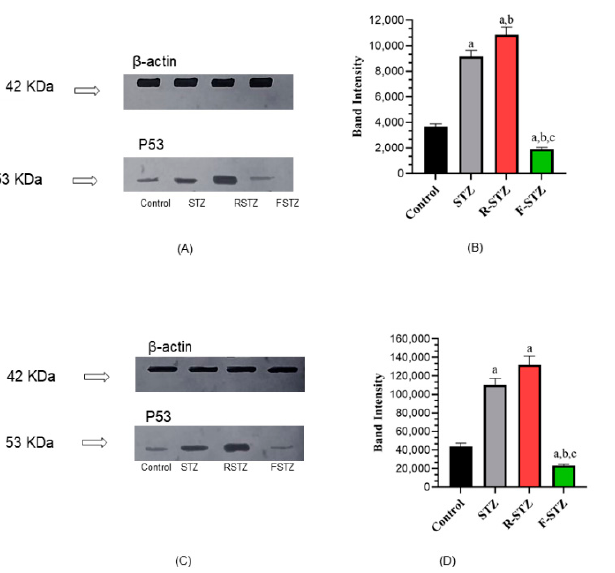
Figure 3. Cellular autophagy marker LC3B protein level in pancreatic and renal tissue samples of the study groups ( A ) Pancreatic representative WB; ( B ) Pancreatic densitometric quantification of WB, bars represent mean ± SD of band inten- sity ( n = 5); ( C ) Renal representative WB; ( D ) Renal densitometric quantification of WB, bars represent mean ± SD of band intensity ( n = 5). (a) Significant difference from normal control group at p < 0.05; (b) Significant difference from STZ group at p < 0.05; (c) Significant difference from R-STZ group at p < 0.05.